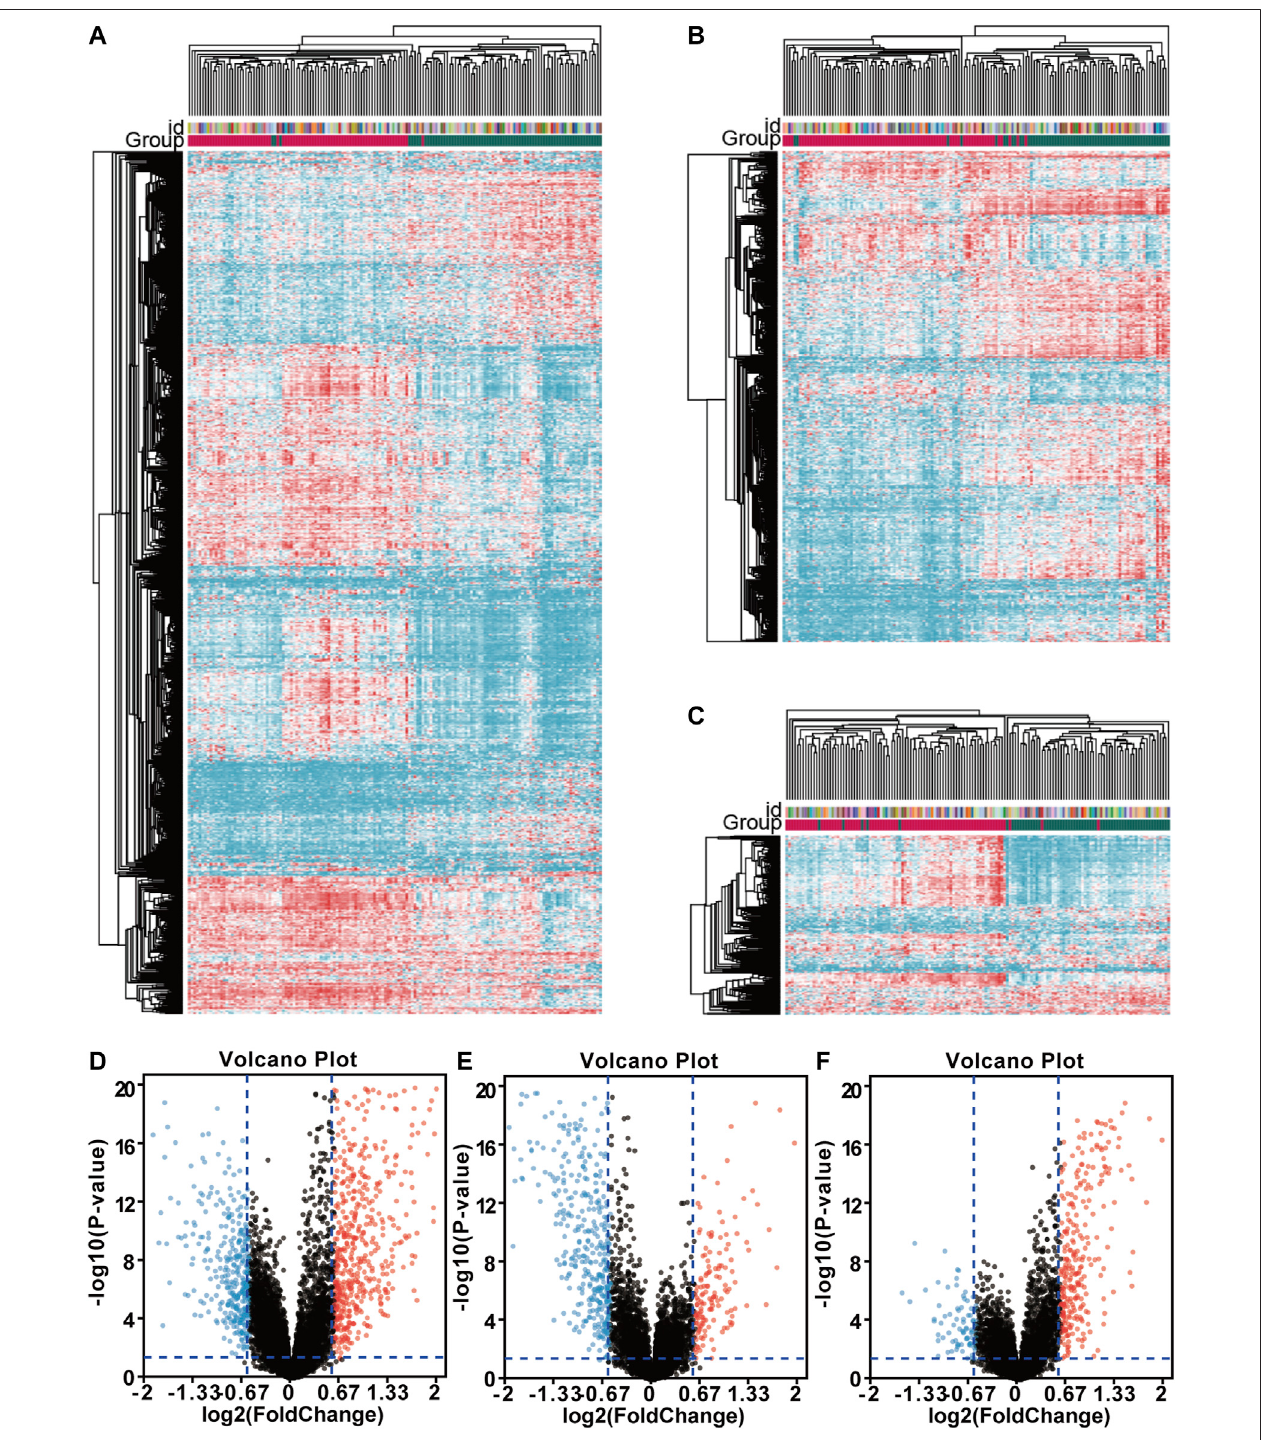
FIGURE 2 | Comparison of differentially expressed genes (DEGs) among gene expression subtypes. The drawing of the heatmap was based on the Hierarchical clustering and Euclidean distance measurement method. The volcano map was drawn using online tools (http://sangerbox.com/). Red and blue indicated upregulated anddown-regulateddifferentialgenes.Foldchange(FC) > 1.5and p -value < 0.05; (A) HeatmapofDEGsbetweentheimmunoreactivegroupandproliferative group; (B) Heatmap of DEGs between the immunoreactive group and mesenchymal group; (C) Heatmap of DEGs between the immunoreactive group and differentiation type; (D) The volcano map between the immunoreactive group and proliferative group; (E) The volcano map between the immunoreactive group and mesenchymal group; (F) The volcano map between the immunoreactive group and differentiation type.